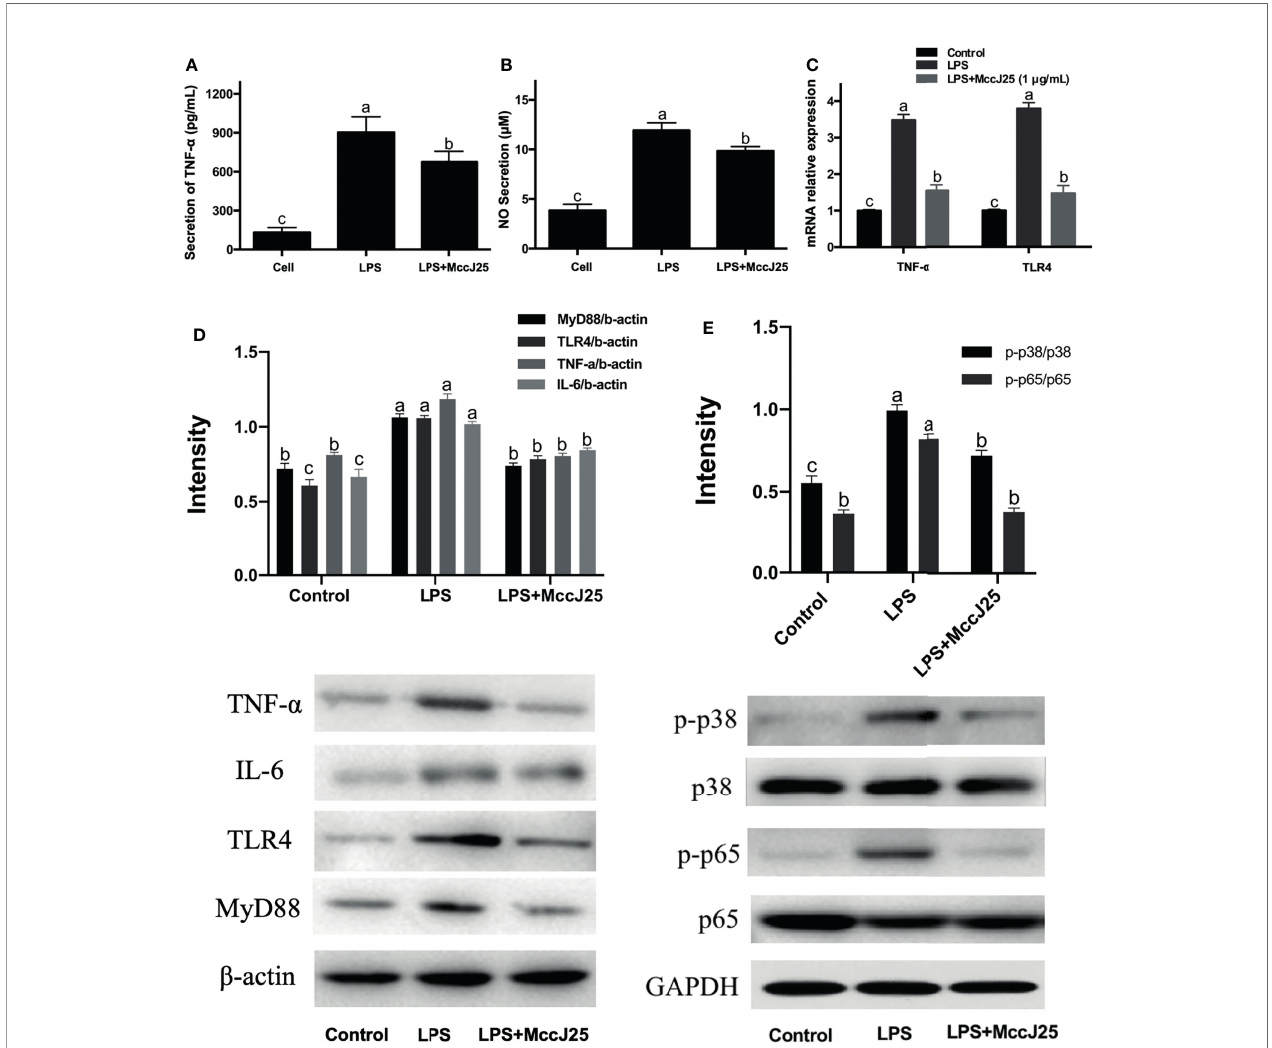
FIGURE 9 | MccJ25 defends against E coli LPS O111:B4-induced in fl ammation in RAW 264.7 cells. (A, B) MccJ25 impedes TNF- a (A) and NO secretion and production (B) in E coli LPS-induced RAW 264.7 cells. (C) RT – qPCR results indicating intracellular expression of TNF- a and TLR4 in E coli LPS-induced RAW 264.7 cells in the presence and absence of MccJ25. Data are presented as the mean ± SEM of 6 biological replicates. MccJ25 signi fi cantly reduced the protein expression of TNF- a , IL-6, TLR4, MyD88 (D) , phosphorylated NF- k B and p38 MAPK (E) in RAW 264.7 cells challenged with LPS by western blotting analysis. Data are shown as the mean ± standard error of mean of 3 biological replicates. Different superscript lowercase letters within each group indicate signi fi cant differences ( P <